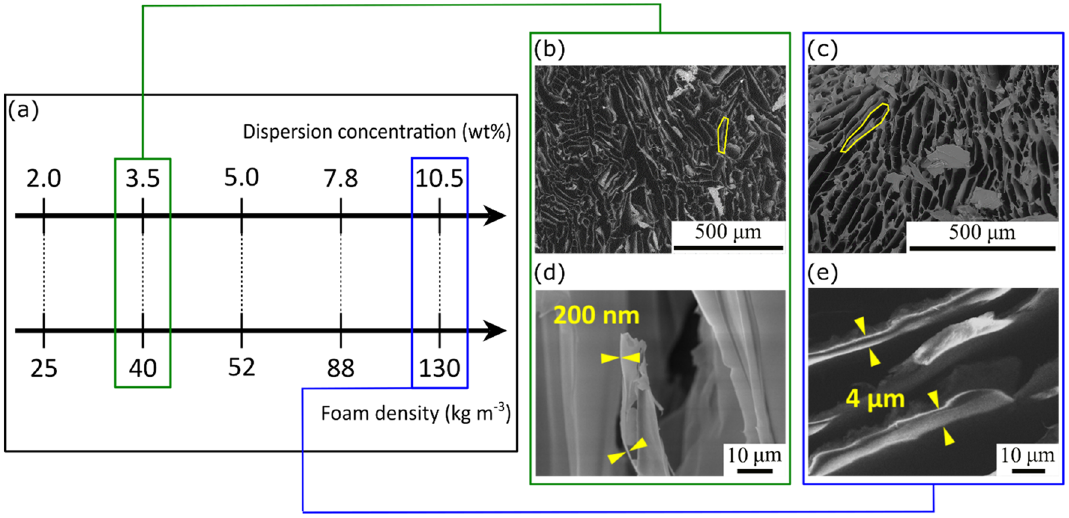
Figure 1. Anisotropic CNC foams prepared by freeze-casting of aqueous dispersions; ( a ) CNC dispersion concentration and corresponding foam density ranges studied herein. Scanning Electron Microscopy (SEM) images of cross-sections of the columnar macroporous structures for foams with densities of; ( b ) 40 kg m −3 ; and; ( c ) 130 kg m −3 . High-resolution Scanning Electron Microscopy (HRSEM) images of foam walls observed in freeze-cast and freeze-dried foams with densities of; ( d ) 40 kg m −3 ; and; ( e ) 130 kg m −3 . The foam wall thicknesses are indicated by yellow